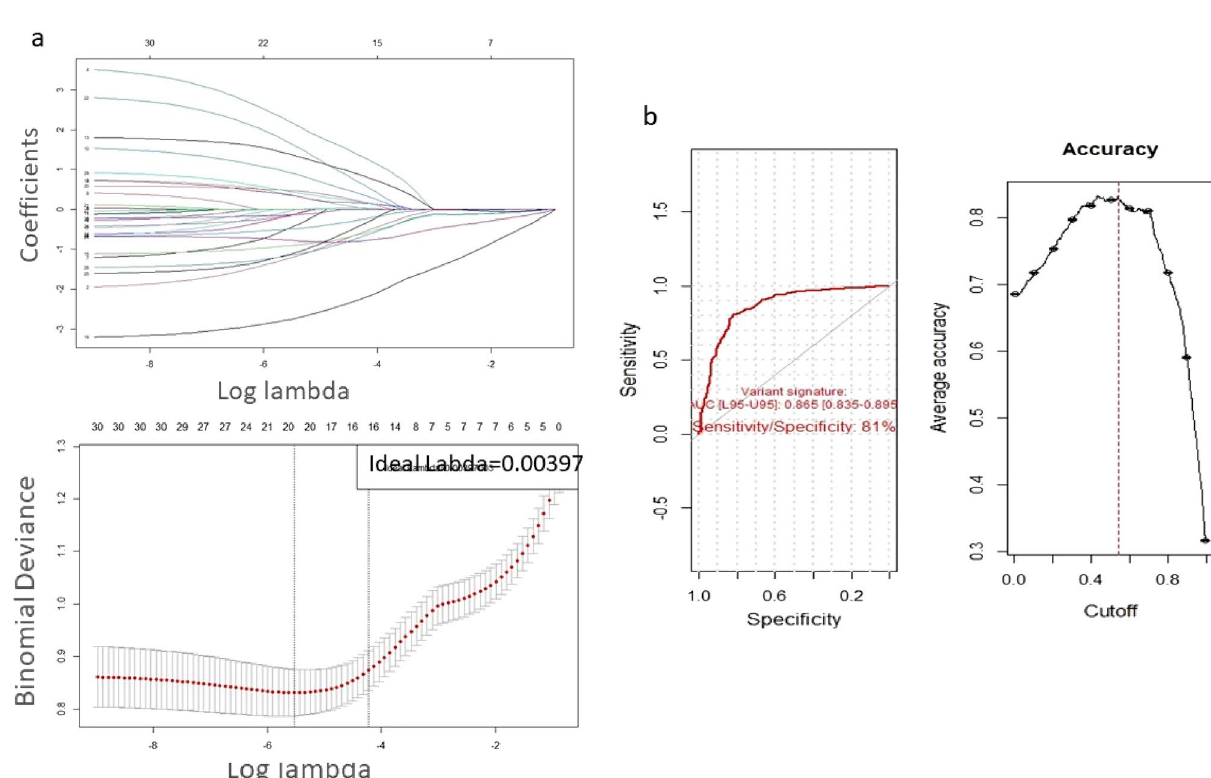
Figure 5. ( a ) The Lasso.model and cv.Lasso model including the selection of the optimal parameter lambda (λ). The optimal λ-value was 0.0021. ( b ) Five genes were finally selected. The ROC and optimum accuracy of 5-genes set for diagnosis of ALS. The values of AUC imply the 5-genes set is an excellent predictor for ALS